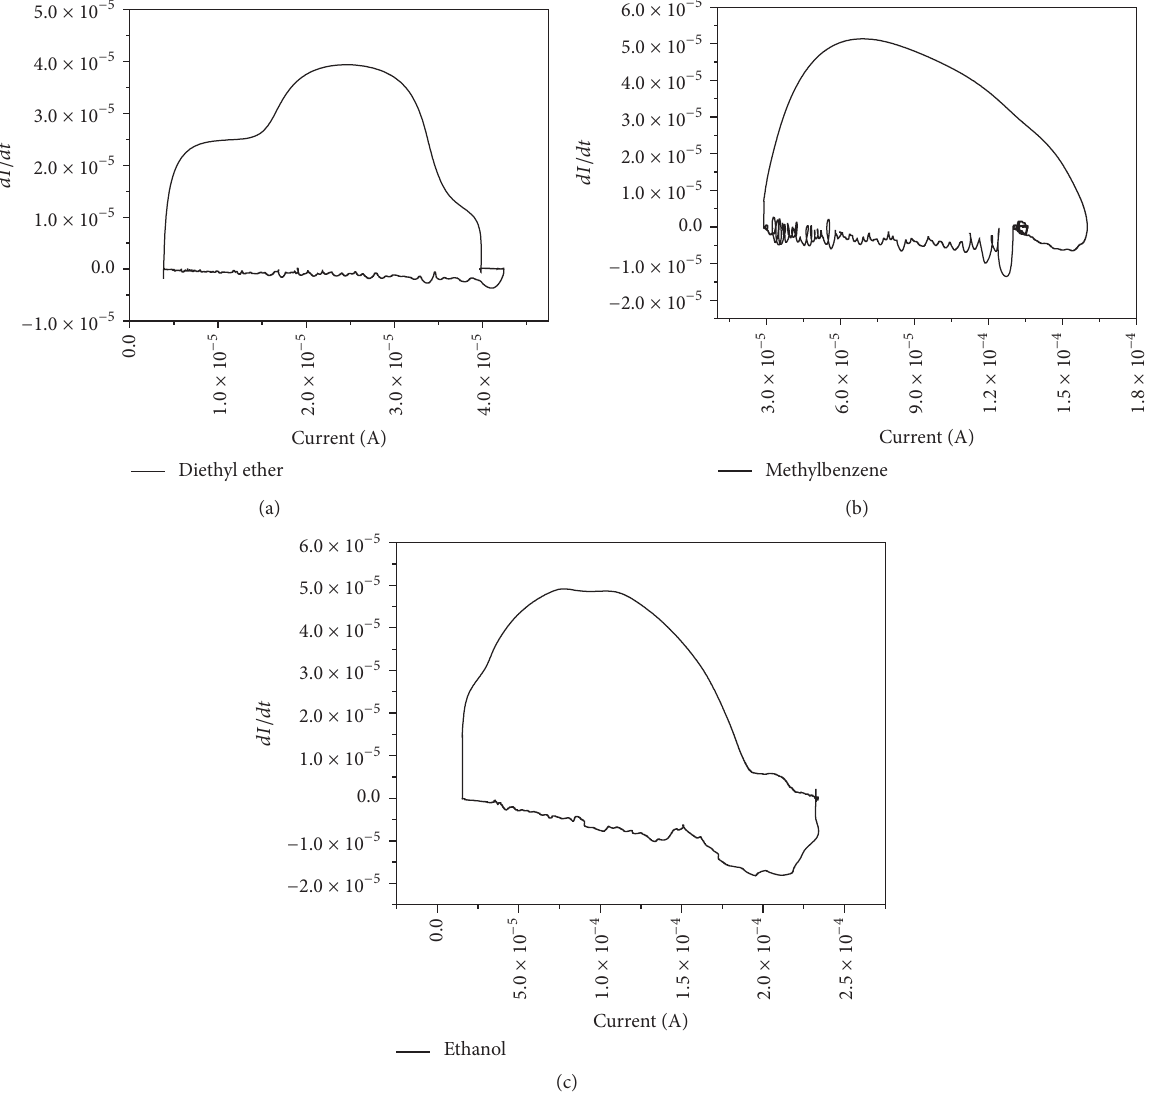
Figure 7: Gas adsorption-desorption curves of the gas sensor based on snowflake-shaped ZnO nanostructures to 50 ppm target gases: (a) diethyl ether, (b) methylbenzene, and (c)